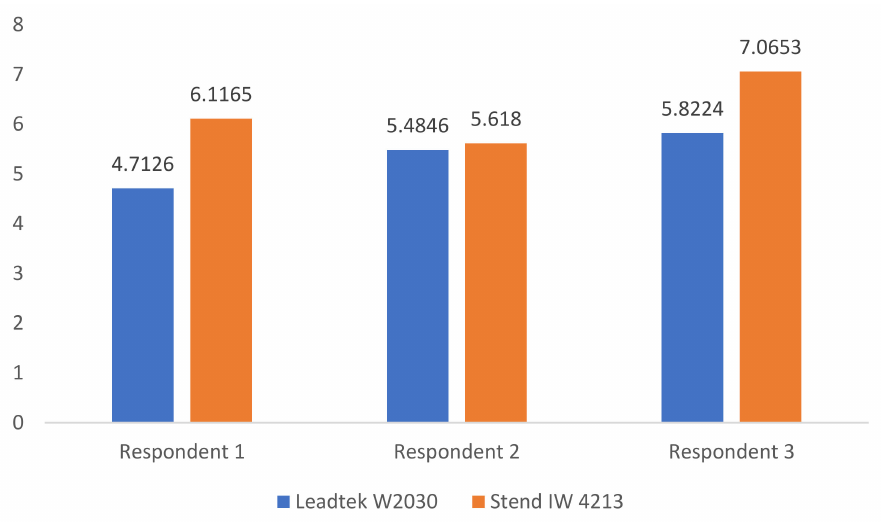
Figure 4. Evaluation scores for the GPU